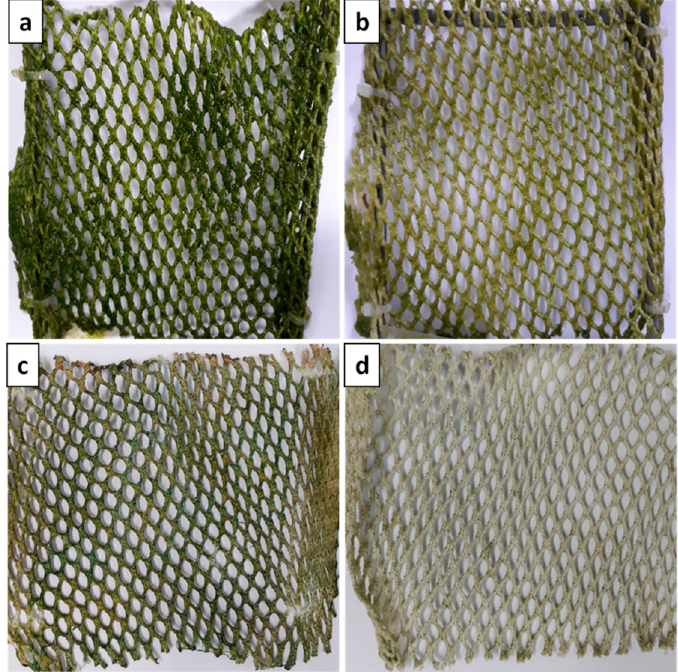
Figure 7. Photographs of the coated ( b , d ) and uncoated nets ( a , c ), before ( a , b ) and after ( c , d ) cleaning with water under high-pressure.